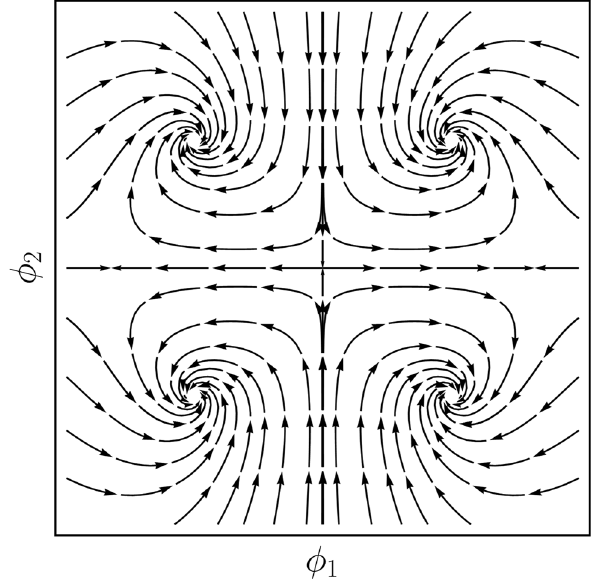
FIG. 5. Mean-field dynamics near the NEFP within the doubly ordered phase with j M 1 j ¼ j M 2 j . The arrows denote how the fields ϕ evolve in time, with four possible steady states. At each i steady state, there is a dissipative relaxation process as well as a “ coherent ” rotation, resulting in a spiraling relaxation to the steady state. Two of the steady states spiral clockwise, while two spiral